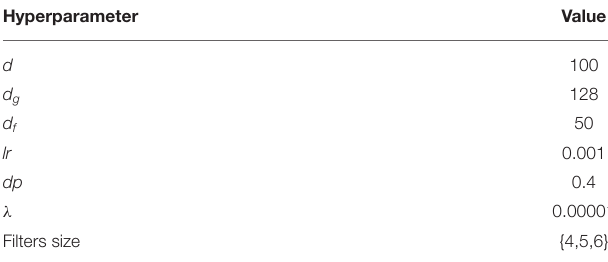
TABLE 3 | The algorithm details of Adversarial Learning. Algorithm 2: Adversarial learning